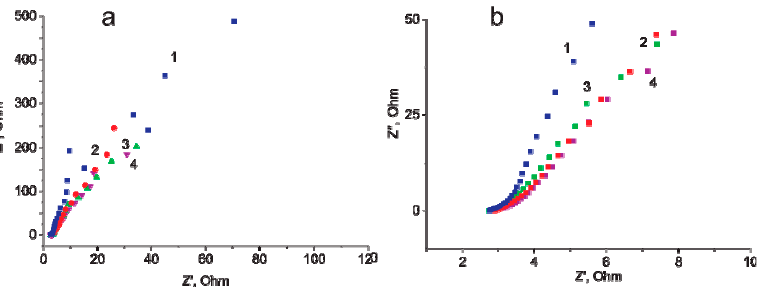
Figure 7. Nyquist plots of 0.5 M Na2SO4 solution at a MWCNT/Al electrode. Oxidation time: 0 min (trace 1), 10 min (trace 2), 20 min (trace 3) and 30 min (trace 4). ( a ) Full frequency range. ( b ) Middle frequency range.